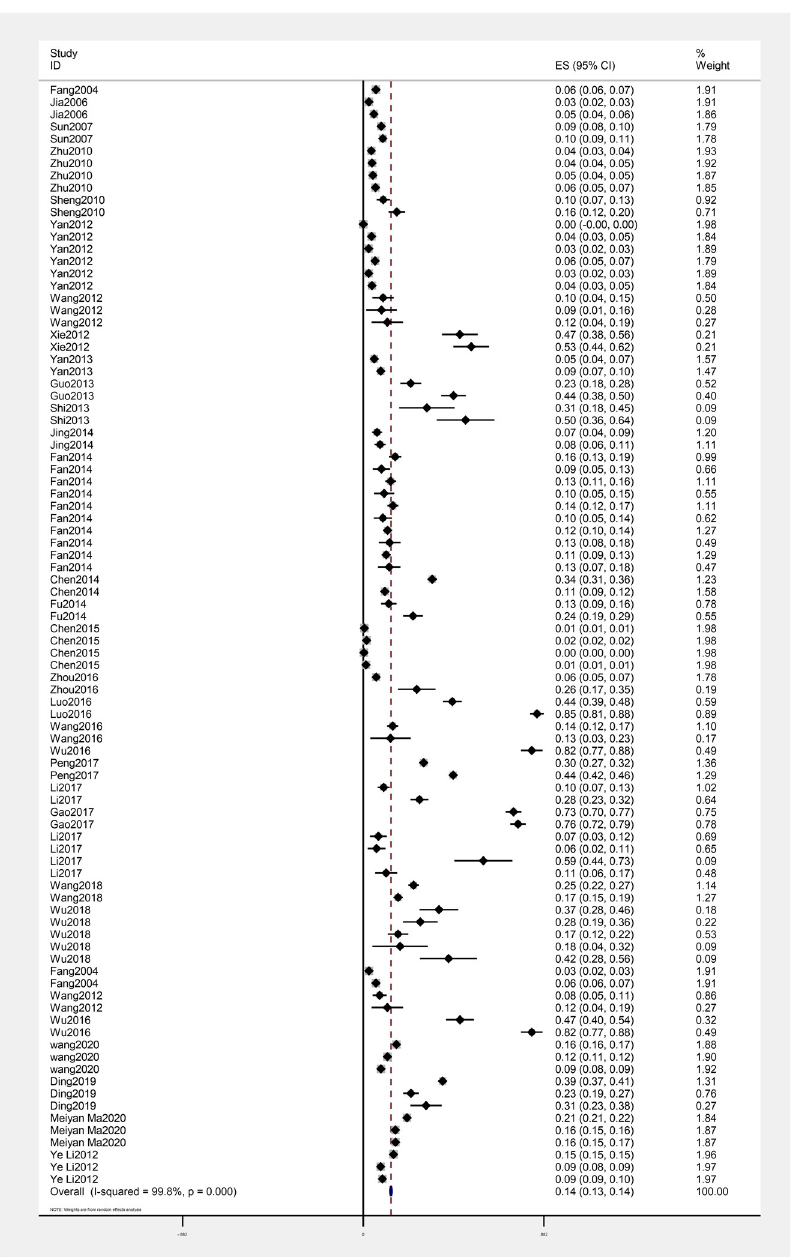
Fig 2. Rate of catastrophic health expenditure of Chinese residents from 2000–2020.